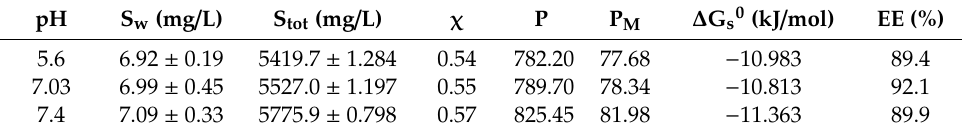
Table 3. Solubility, encapsulation efficiency and calculated parameters of drug-loaded polymeric micelles.